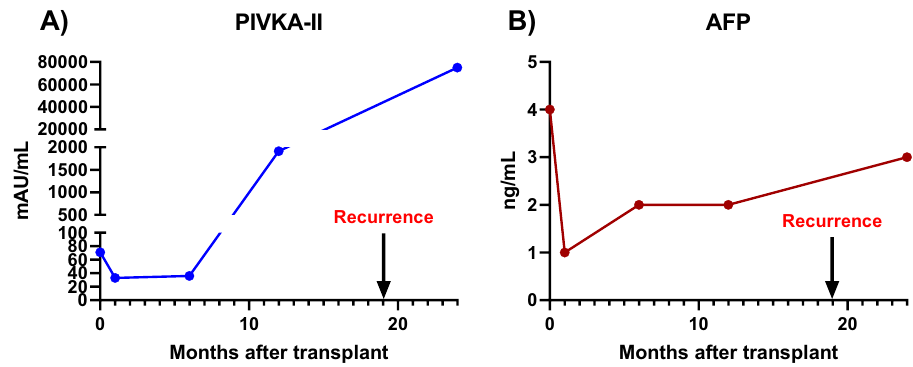
Figure 2. Evolution of PIVKA-II and AFP levels after OLT in patient 23. OLT orthotopic liver transplant.